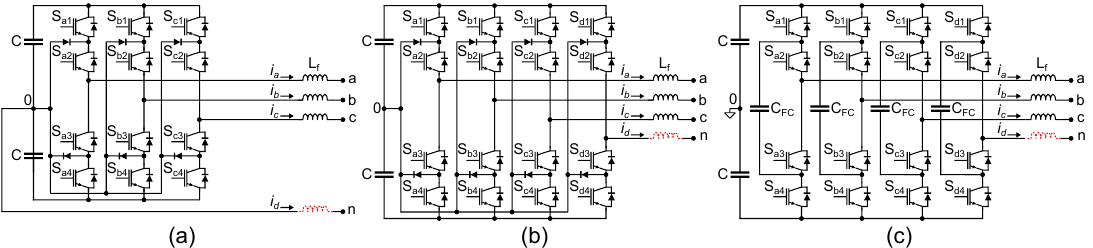
Figure 9. Main topologies of multilevel four-wire APFs: ( a ) three-leg neutral-point-clamped (3L-NPC); ( b ) four-leg neutral-point-clamped (4L-NPC); ( c ) four-leg flying capacitor (4L-FC). The optional fourth inductance is drawn with dashed red